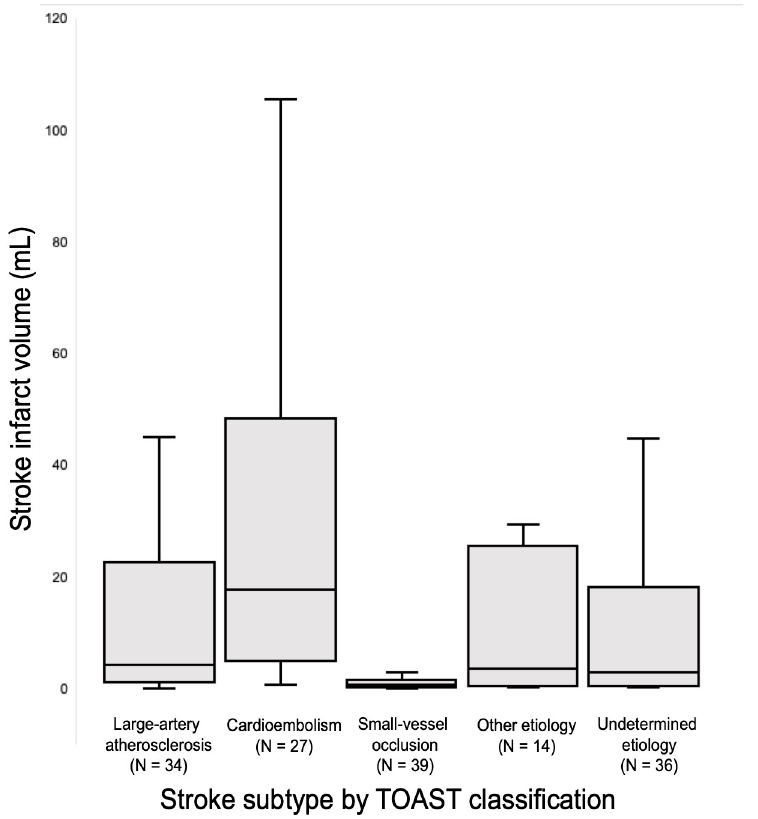
Fig 2. Box and whisker plots of stroke infarct volume across different stroke etiologies.